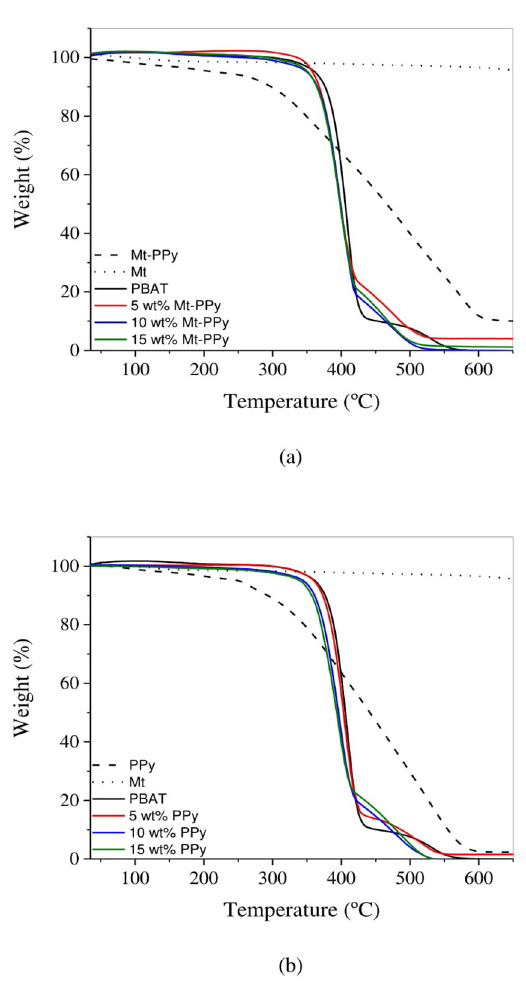
Figure 7. TG curves of (a) PBAT/Mt-PPy and (b) of PBAT/PPy. Table 2. Initial weight loss temperature (T degradation temperature (T Mt-PPy and